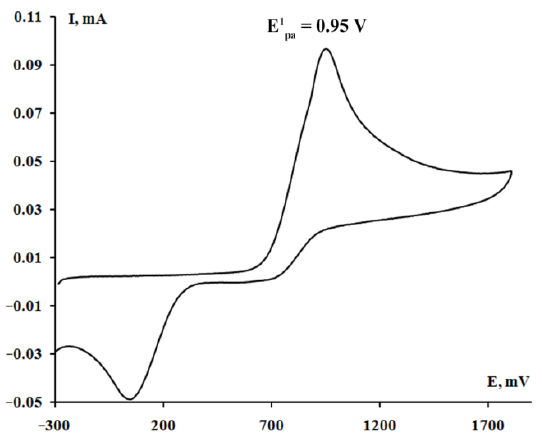
Figure 12. CV of complex 5 in the sweep range of − 0.3 to 1.8 V (CH 2 Cl 2 , GC, C = 3 × 10 − 3 M, 0.1 M Bu 4 NClO 4 , vs. Ag/AgCl/KCl(sat.)).